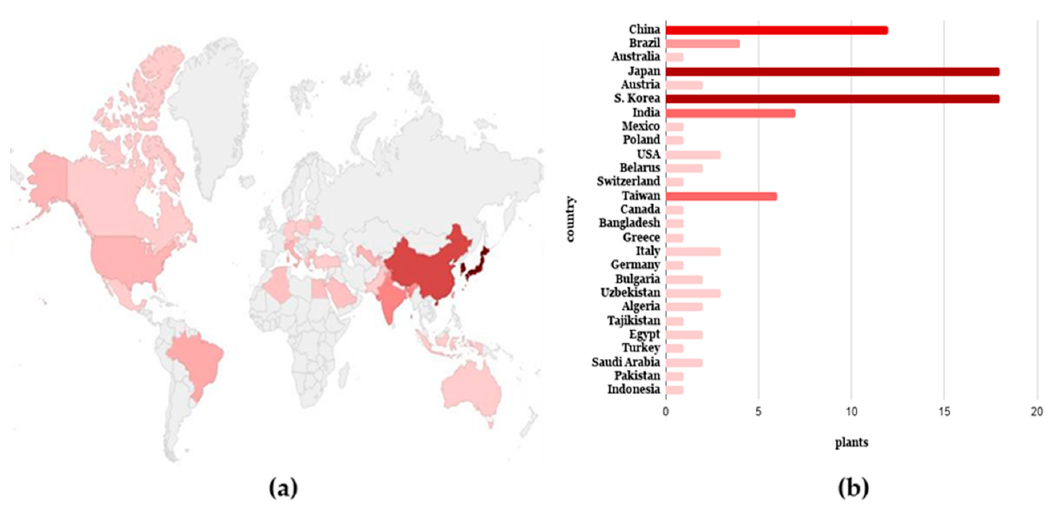
Figure 3. Worldwide distribution of the plants containing pectolinarin ( a ), with indication of their number from each country ( b ).